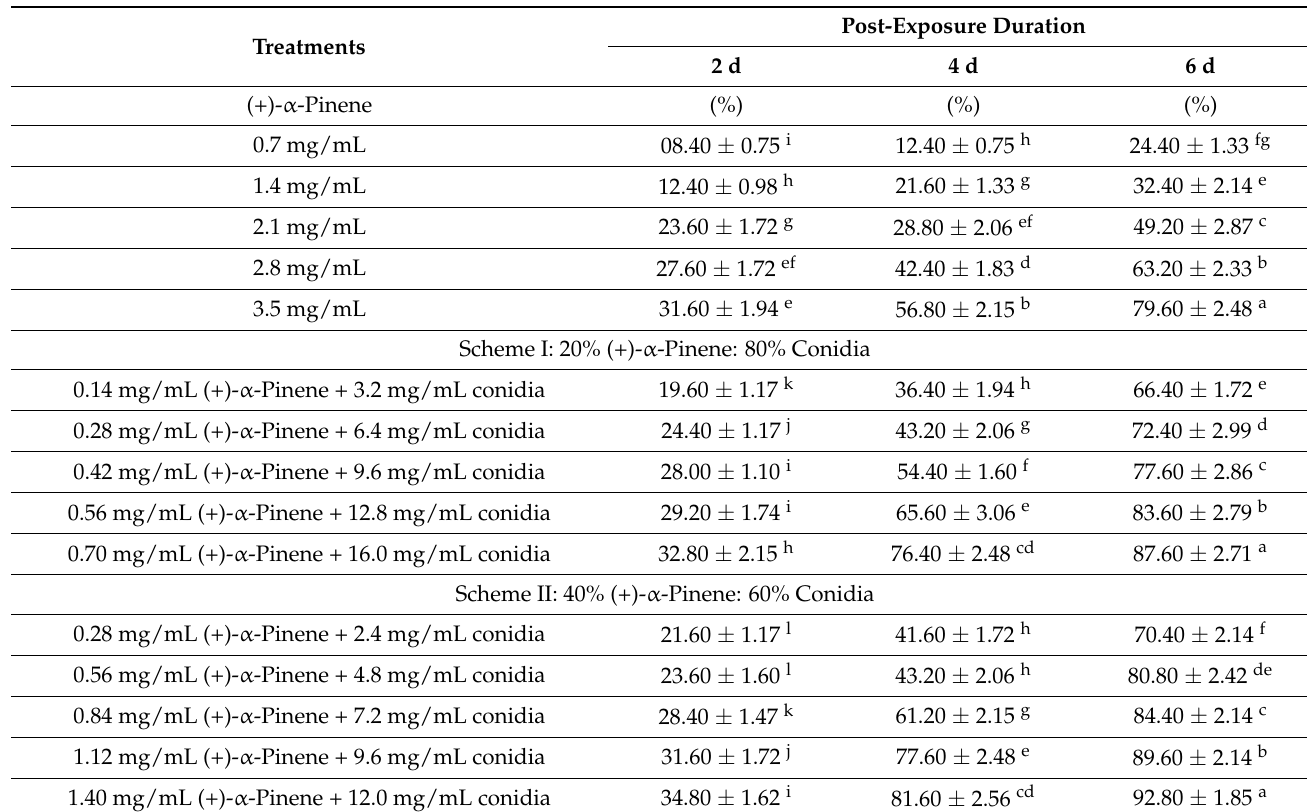
Table 4. Cumulative percent mortality of date palm dust mites fed on date palm leaf-disk treated with various proportions of (+)- α -Pinene and B. bassiana ARSEF 8465 alone or in different combinations.